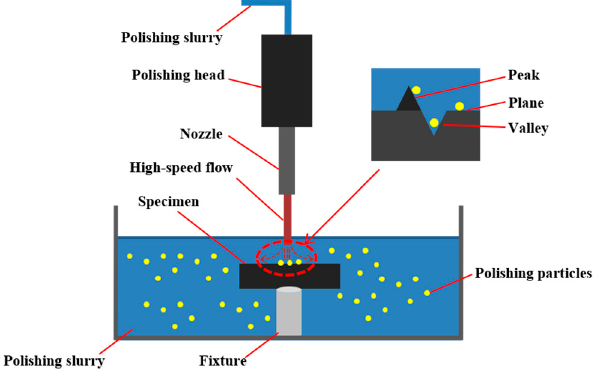
Figure 2. Mechanism of jet polishing.